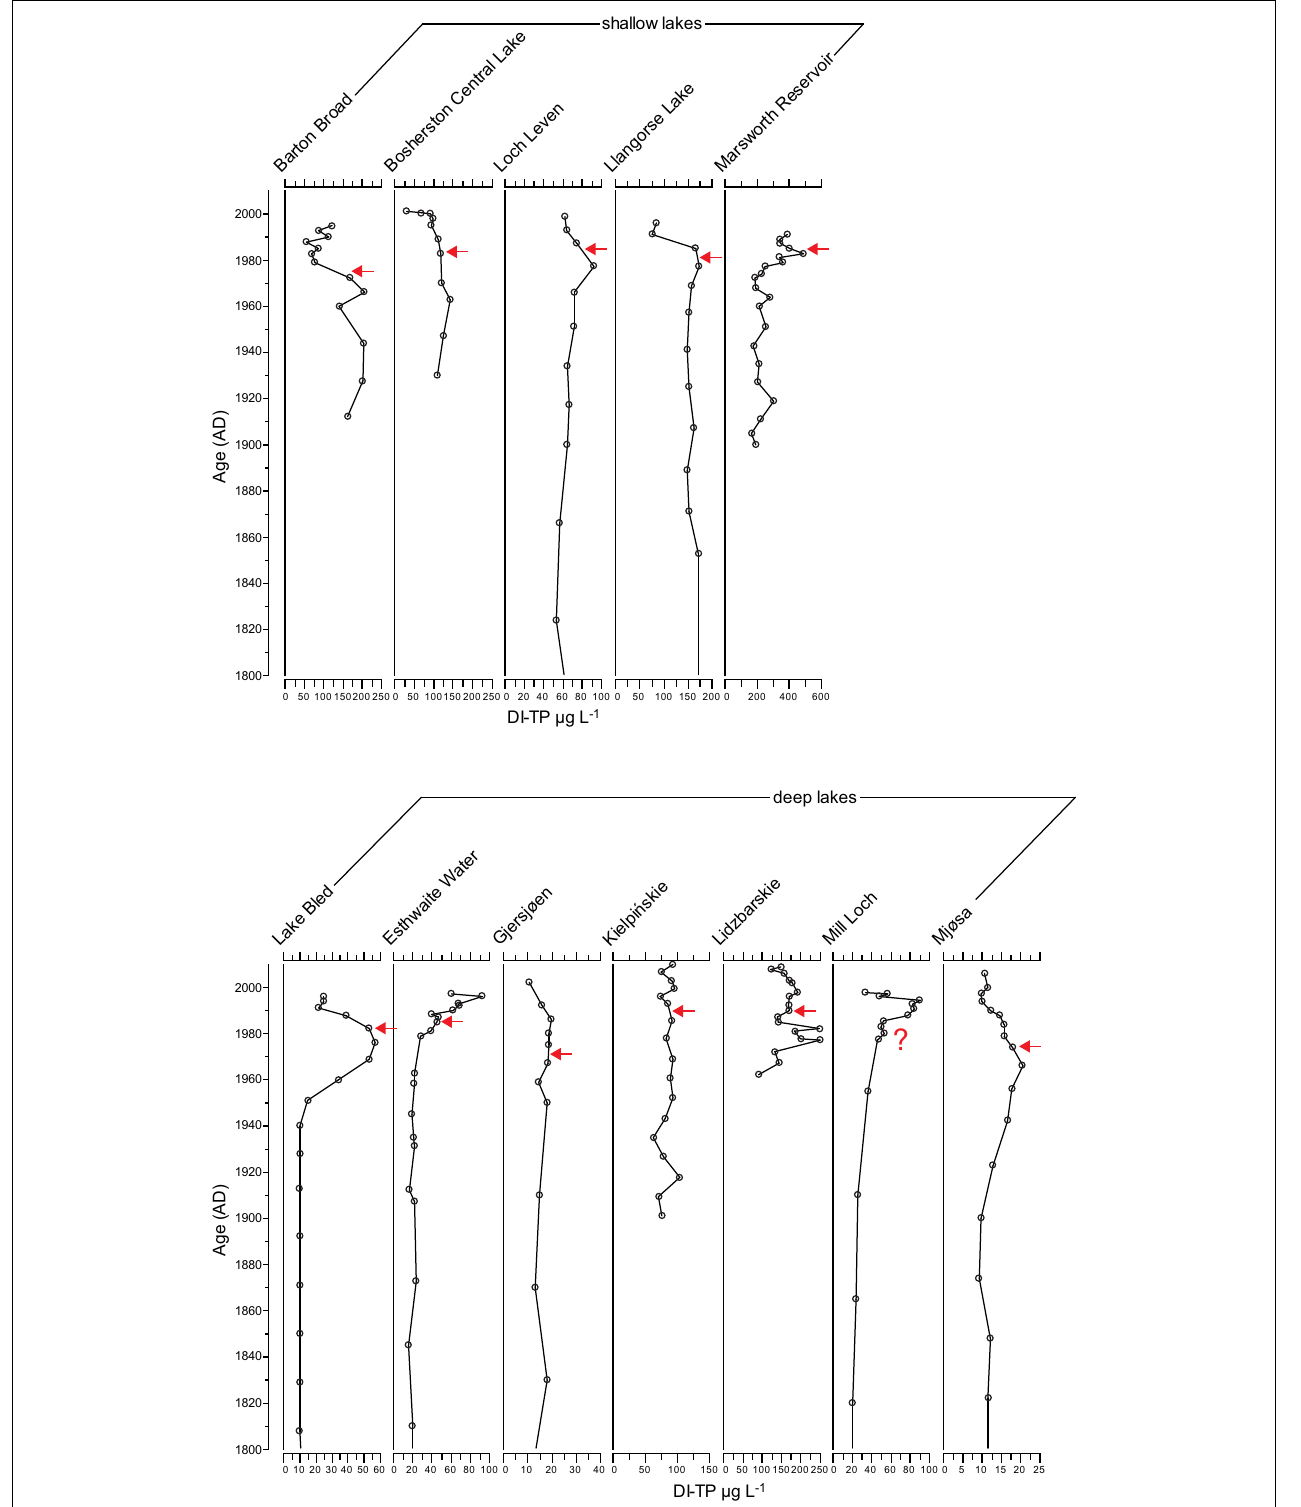
FIGURE 5 | Diatom-inferred TP (DI-TP) reconstructions for the 12 study sites. Timing of first nutrient reduction is shown by the arrow.